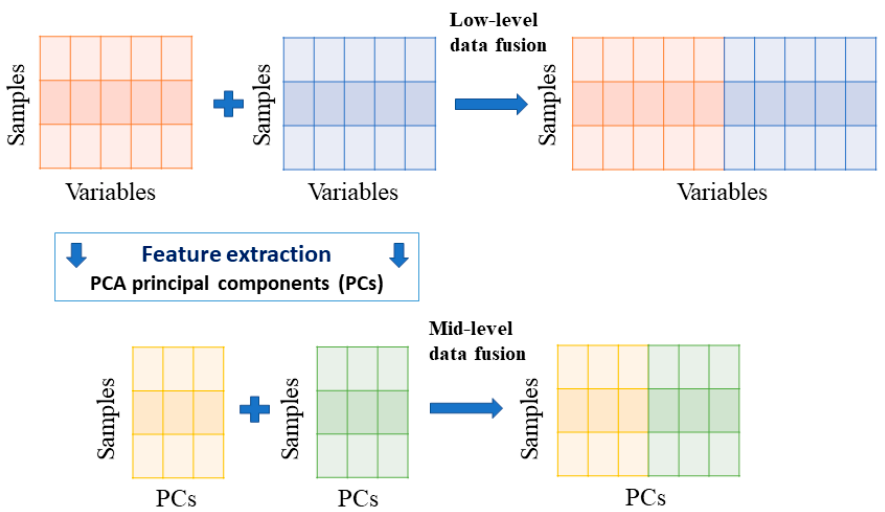
Figure 7. The scheme of the data fusion approaches.